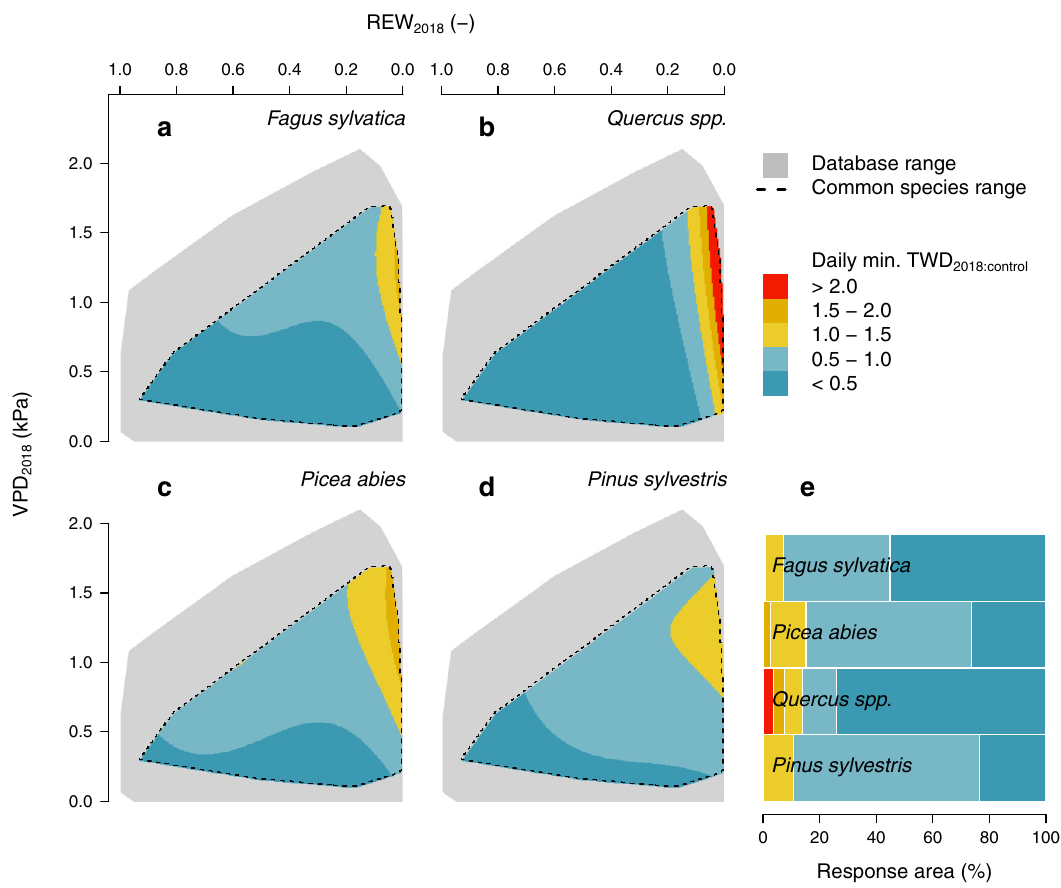
Fig. 4 Species-speci fi c response of tree water de fi cit (TWD) ratio to vapour pressure de fi cit (VPD) and relative extractable water (REW) in the hydrometeorological space for most abundant and economically valuable tree species in Europe. a – d , Linear-mixed effect model output of the ratio of the daily minimum TWD during the 2018 heatwave compared to the 95 th percentile of the control period (TWD 2018:control ), while VPD 2018 and REW 2018 refer to the absolute values during 2018 heatwave. All trees of Fagus sylvatica , Quercus spp . ( Q. robur/petraea ), Picea abies and Pinus sylvestris within the database are considered. From the hydrometeorological space range of the entire database (indicated in grey), models have been adjusted for the common climatic range of the selected species only (indicated with dotted lines; see Supplementary Fig. 4 for the climate range of each species). e Bars indicate the percentage of the hydrometeorological space covering different ranges of min. TWD 2018:control values (see